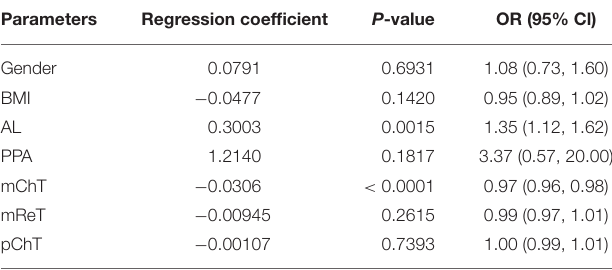
TABLE 6 | Associations of fundus tessellation severity with ocular and systemic parameters with scleral thickness.